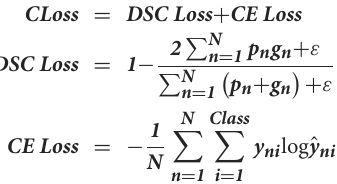
WMHs segmentation from the first stage. The CLoss was defined by a Dice similarity (DSC) loss from the segmentation stage and cross-entropy (CE) loss from the differentiation